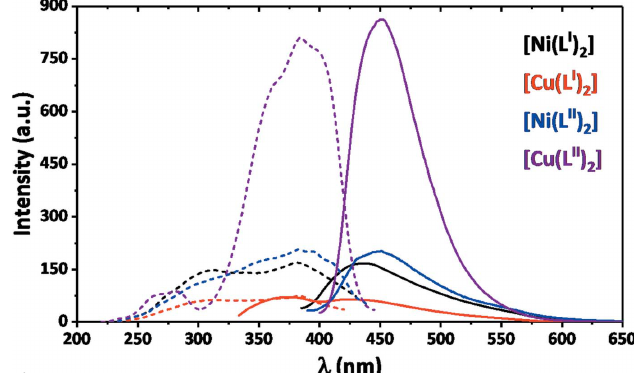
Figure 9 Emission {straight line; (cid:7) exc = 380 nm for [Ni( L I,II ) 2 ] and [Cu( L II ) 2 ], and 310 nm for [Cu( L I ) 2 ]} and excitation {dashed line; (cid:7) em = 435 nm for [Ni( L I ) 2 ] and [Cu( L I ) 2 ], and 450 nm for [Ni( L II ) 2 ] and [Cu( L II ) 2 ]} spectra for the reported complexes in CH 2 Cl 2